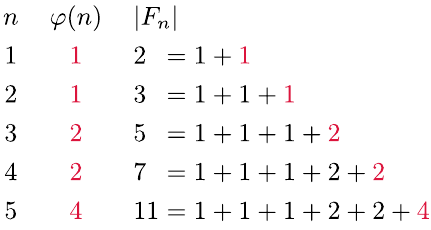
Figure 1. Visualization of the link between Euler’s totient function ϕ( n ) and the length of the Farey sequence F n